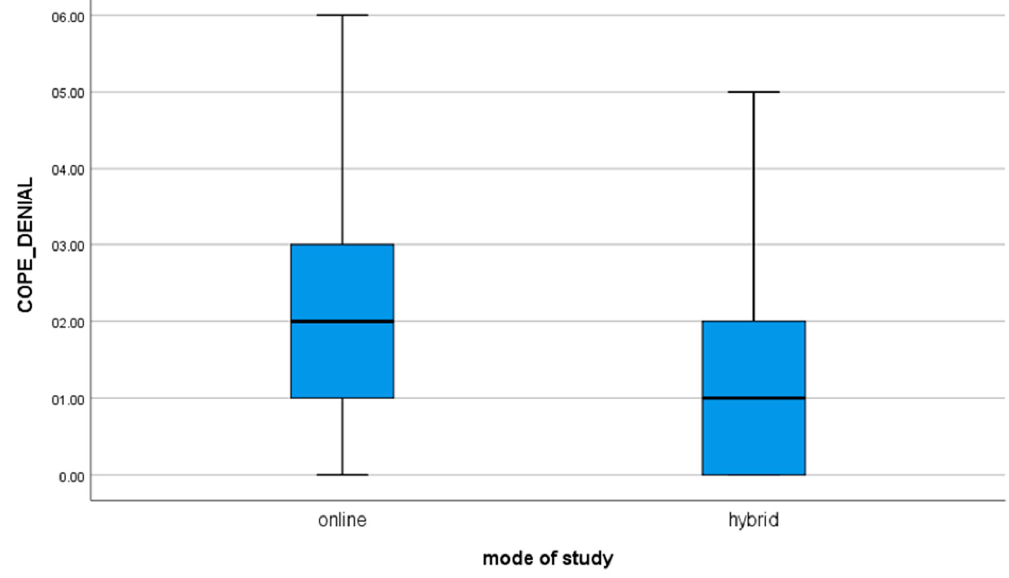
Figure 6. For the variable COPE_DENIAL.